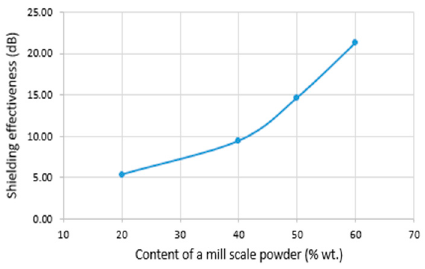
Figure 24. SE dependence of content of iron scale flakes. Frequency—23 GHz.